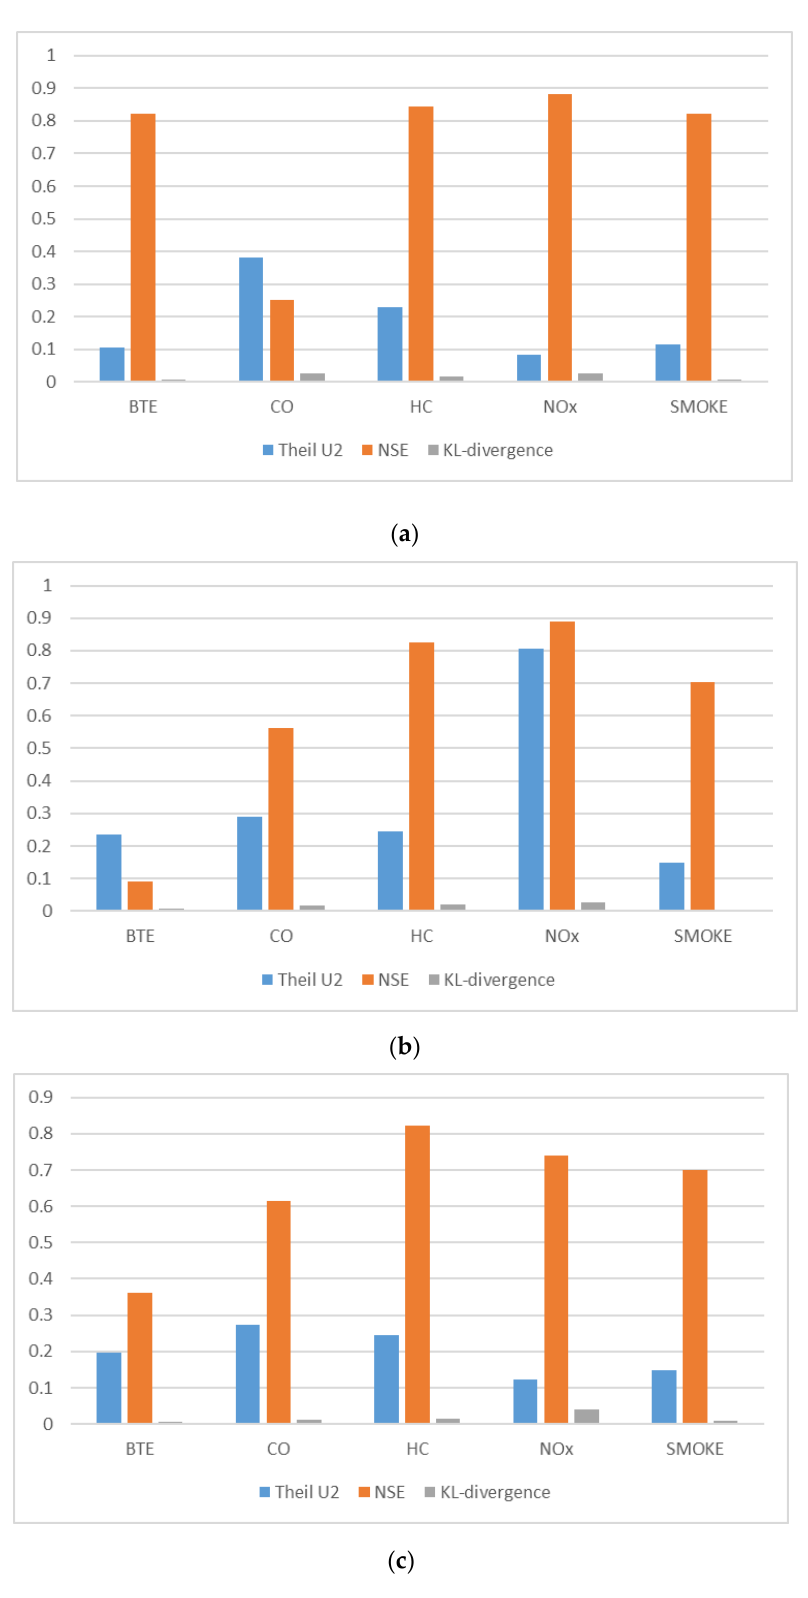
Figure 6. Representation of values obtained with respect to Theil U2, NSE, and KL-divergence of the model for (a ) 3 neurons, ( b ) 5 neurons, and ( c ) 7 neurons.